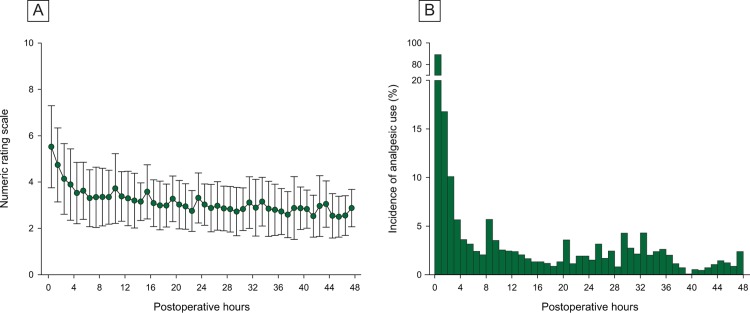
Changes in pain scores and analgesic consumption for 48 hours after robotic thyroidectomy.A: Postoperative pain is quantified by 11-point (0–11) numeric rating scale. Data are expressed as mean ± SD (symbol and error bar). B: The number of patients requiring analgesic for each hour is divided by the total number of patients. Data are expressed as incidence (%).